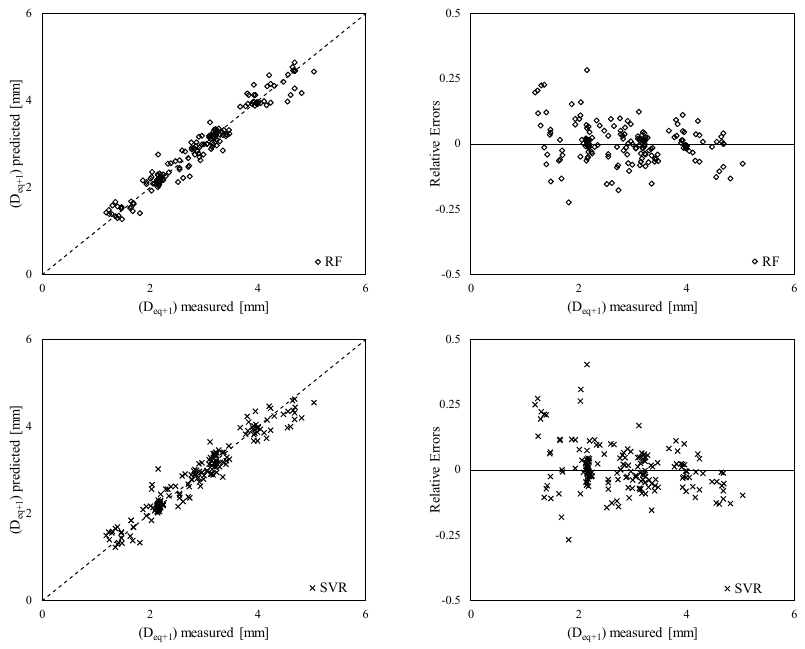
Figure 7. Equivalent diameter prediction “Model 2”: in the left column, predicted versus experimental values, in the right column, residuals versus experimental values.